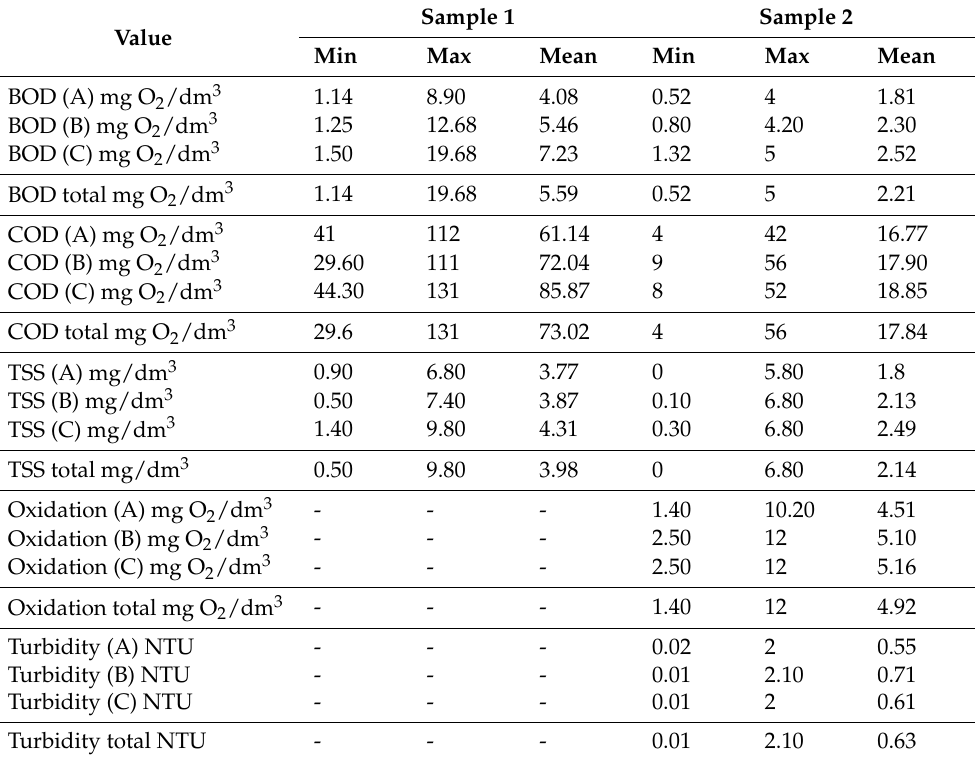
Table 2. Characteristics of treated wastewater (sample 1) and renewed water (sample 2) in the pilot plant.